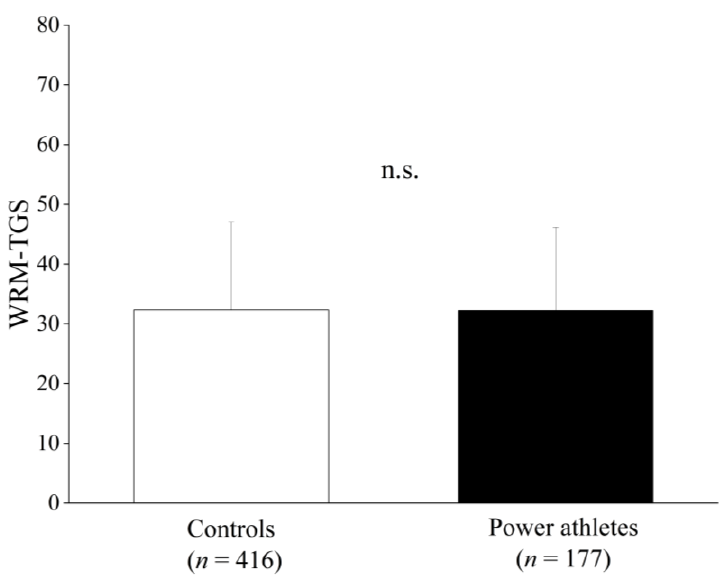
Figure 3. WRM of power-oriented athletes and the controls. The values are presented as mean ± SD.